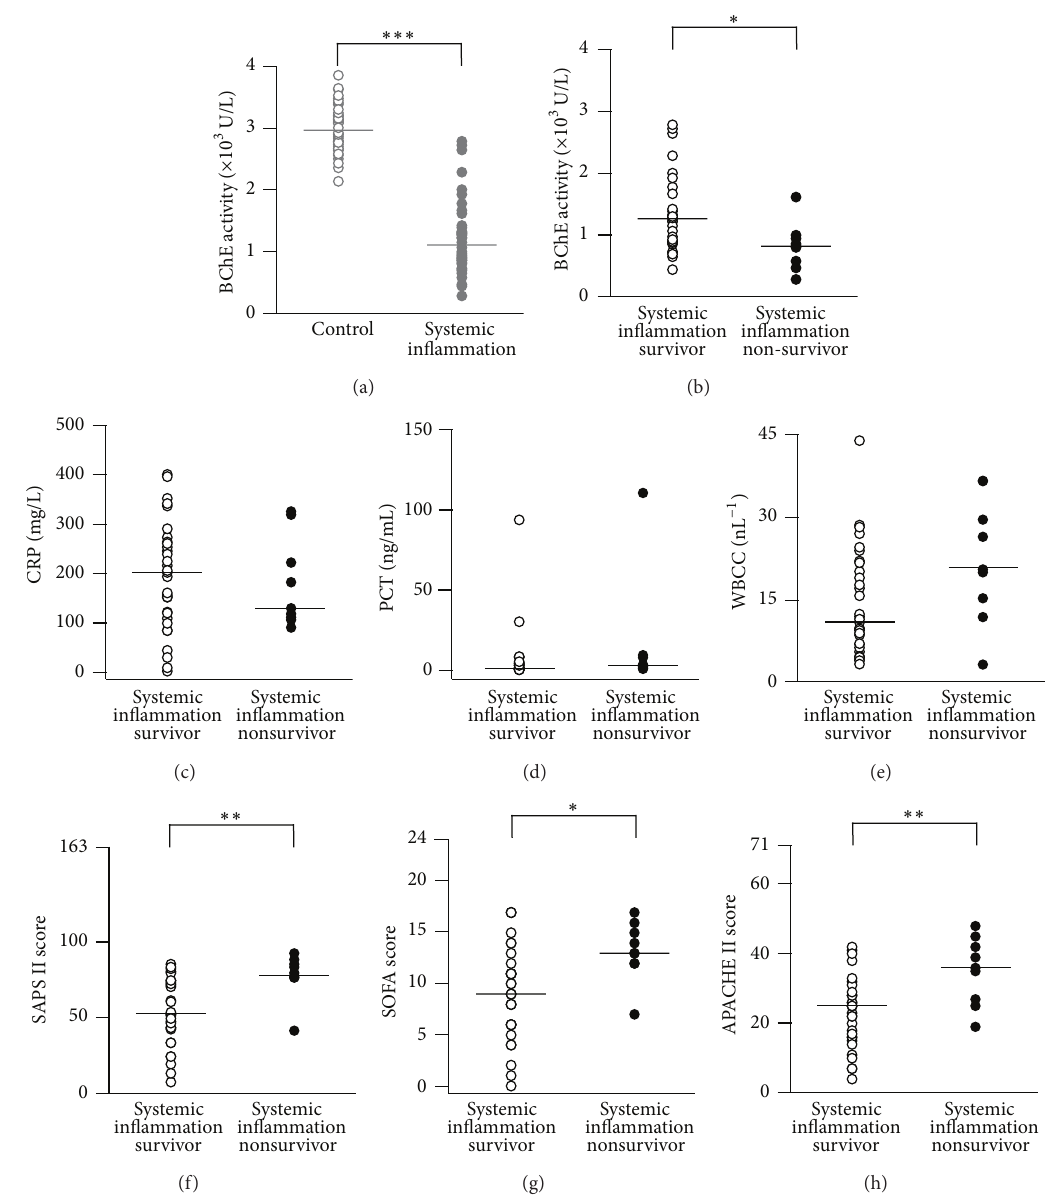
Figure 1: Reduced BChE activity in patients with systemic inflammation. (a) Scatter plots represent results of BChE point-of-care-testing (POCT) obtained from healthy volunteers (gray open circles, control) and patients diagnosed with systemic inflammation (gray closed circles, see Table 1). (b) Based on subsequent 28-day-survival analysis, patients were further divided into the survivor and nonsurvivor subgroups (black open and closed circles, resp.). ((c)–(h)) Histograms represent concurrent measurements of inflammation biomarkers CRP ( 𝑛 = 40 measurements (c)), PCT ( 𝑛 = 34 measurements (d)) and WBCC ( 𝑛 = 40 measurements (e)) and disease severity scores (SAPS II, SOFA, and APACHE II, 𝑛 = 40 measurements each (f), (g), and (h)) from survivors (open circles) and nonsurvivors (closed circles). Bars are median values. ∗ 𝑃 < 0.05 , ∗∗ 𝑃 < 0.01 , and ∗∗∗ 𝑃 < 0.001 (Mann-Whitney test). BChE: butyrylcholinesterase; CRP: C-reactive protein; PCT: procalcitonin; WBCC: white blood cell count; SAPS: simplified acute physiology score; SOFA: sequential organ failure assessment; APACHE: acute physiology and chronic health